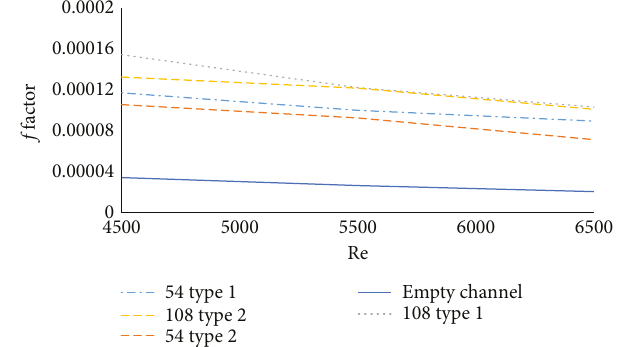
Figure 10: Friction factor — Reynolds